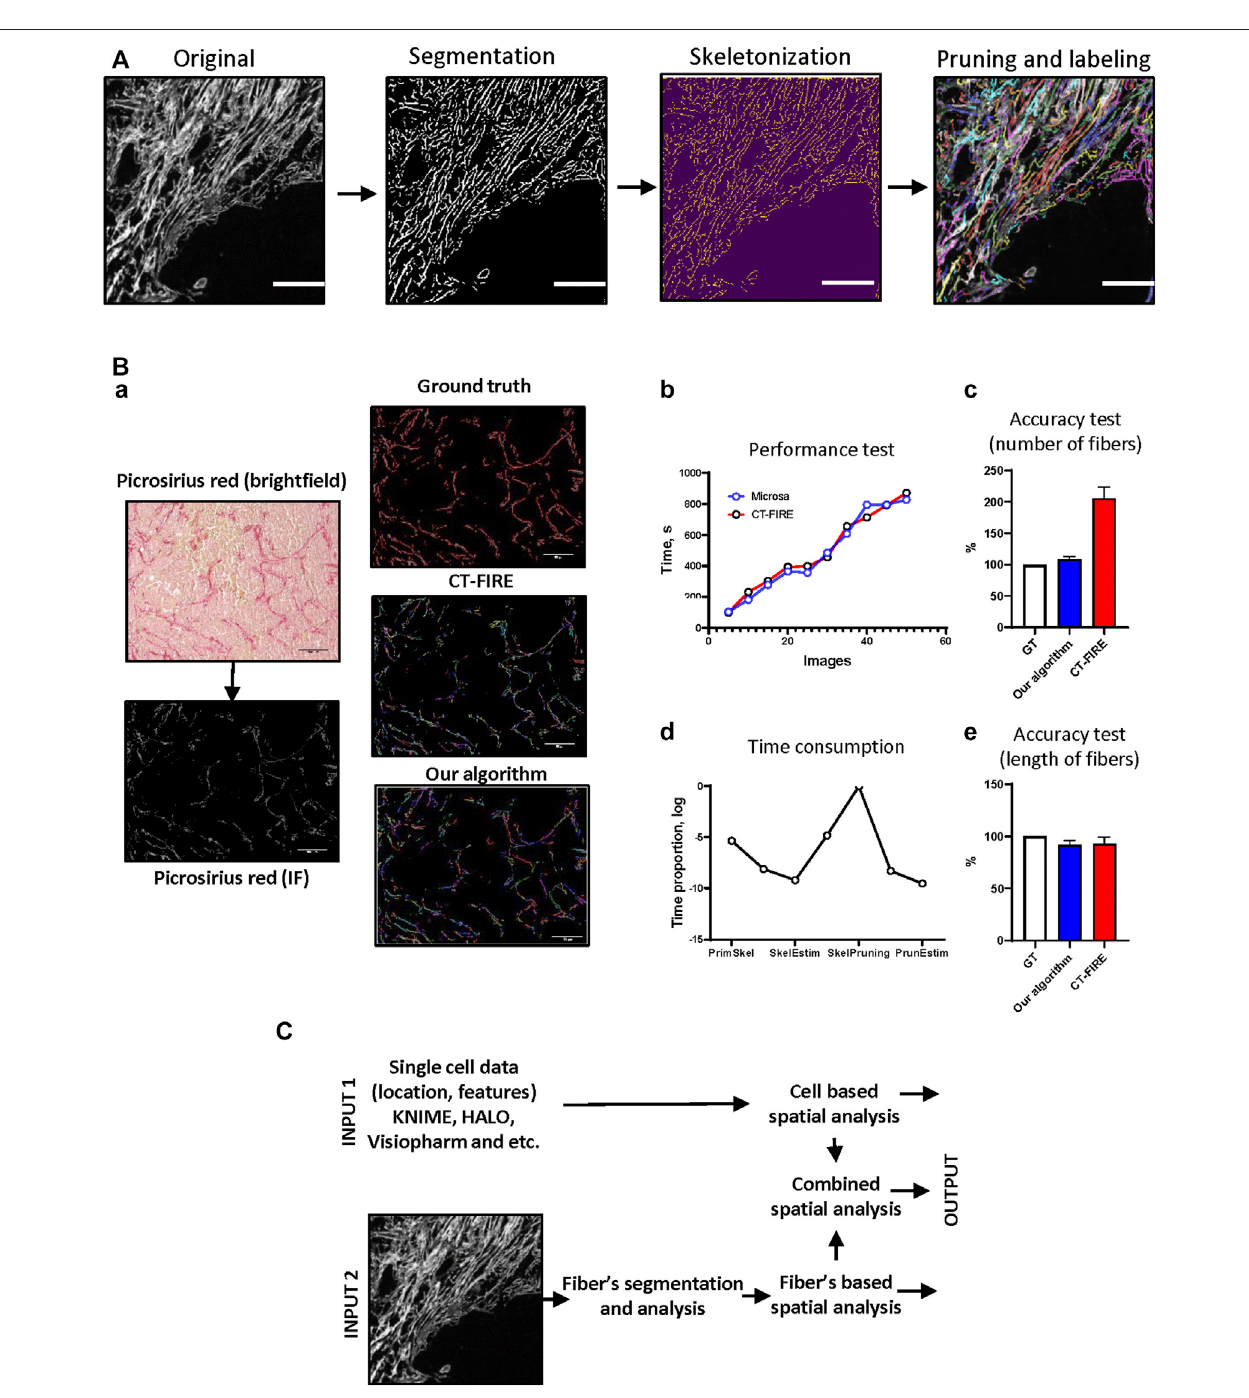
FIGURE 2 | Package implication. (A) The algorithm for fi ber segmentation and labeling. “ Original image ”— image with visualized fi bers. “ Segmentation ”— background/foreground separation, highlighting of separated fi bers using “ Original image ” , “ Skeletonization ”— erosion of single fi bers until the thicknessisequalto1pixel, “ Pruning ”– removingadditionalbrunches, “ Labeling ”— indexingofsegmentedsingle fi bers.Scalebar100 μ m. (B) Algorithmexecutiontests. Mousemammaryglandtumortissuewasanalyzedmanually(groundtruth),usingCT-FIREsoftwareandouralgorithm(Microsa) (a) .Collagen fi berswerevisualized using Picrosirius red staining. Image size – 1920 x 1440 pixels, scale bar — 100 μ m. Performance test of CT-FIRE and our algorithm demonstrates time required for the analysis of different numbers of images (b) . Time consumption test shows proportion of time required for each procedure during fi ber segmentation and labeling algorithm execution (d) . Accuracy tests demonstrate precision of CT-FIRE and our algorithm performance in comparison to manually analyzed data (c, e) . (C) The scheme of cell and fi ber segmentation and labeling algorithms with subsequent spatial analysis. Three types of output: cell-based spatial analysis, fi bers-based spatial analysis and combined spatial analysis.